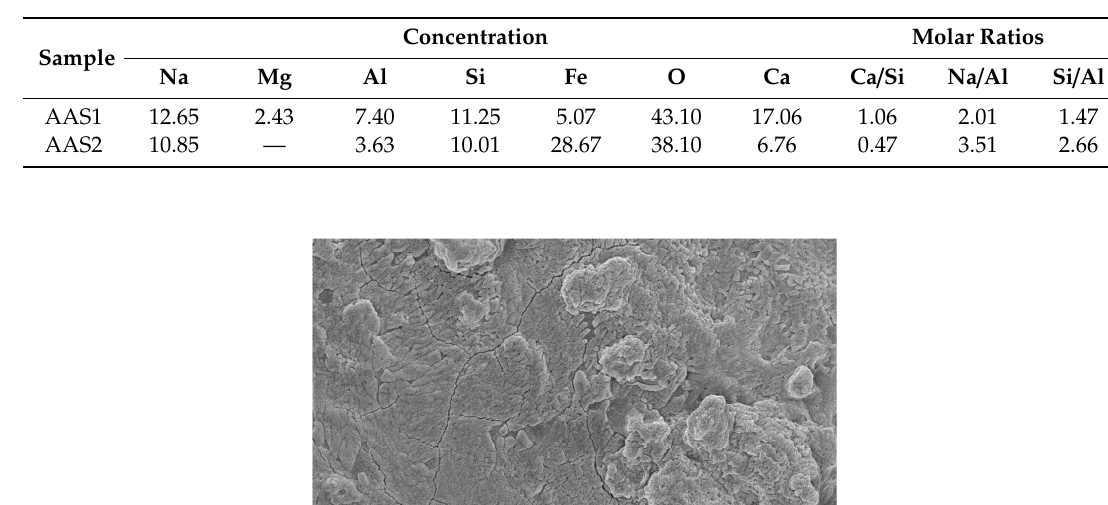
Table 3. Elemental analysis of